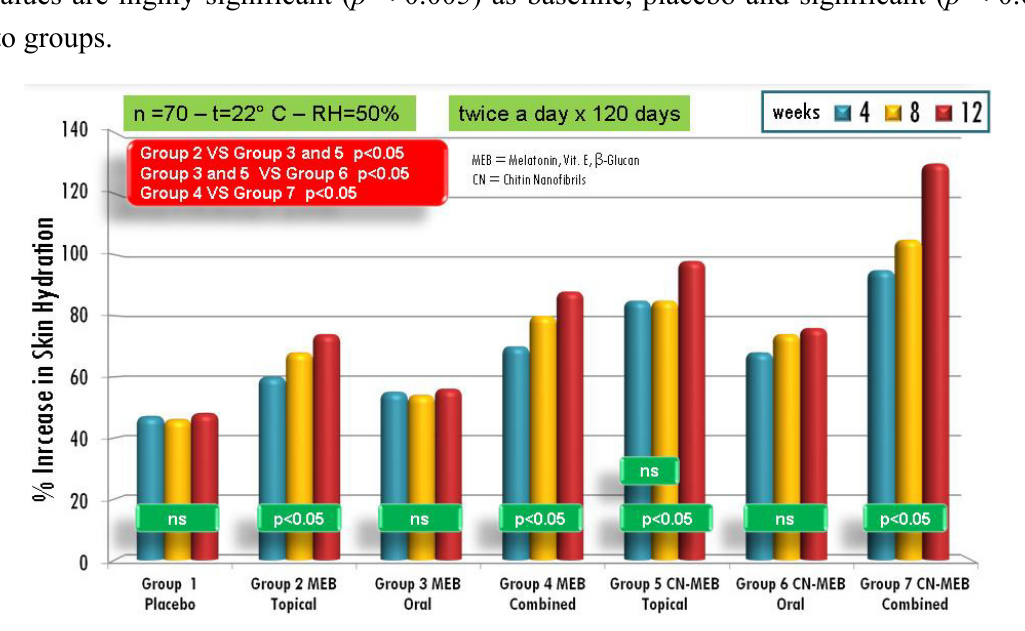
Figure 12. Skin elasticity of photo-aged healthy subjects treated topically and/or orally by antioxidant compounds complexed with chitin nanofibrils (% increase vs. baseline values). All p values are highly significant ( p < 0.005) as baseline, placebo and significant ( p < 0.05) as to